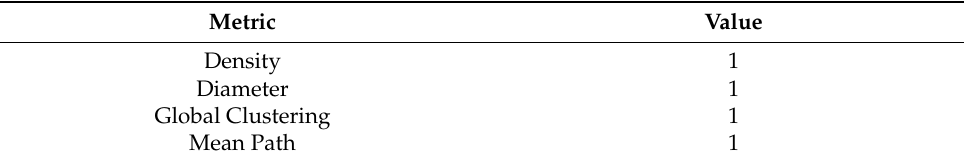
Table 3. Global network metrics from the undirected network for the male (Sirius), female (Salween), and two cub tigers (Serikin and Shima) at Parc des Félins.